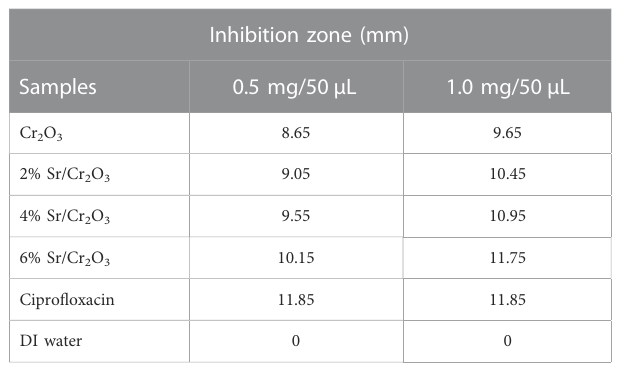
TABLE 1 The bactericidal potential of Cr 2 O 3 and Sr-doped Cr 2 O 3 .